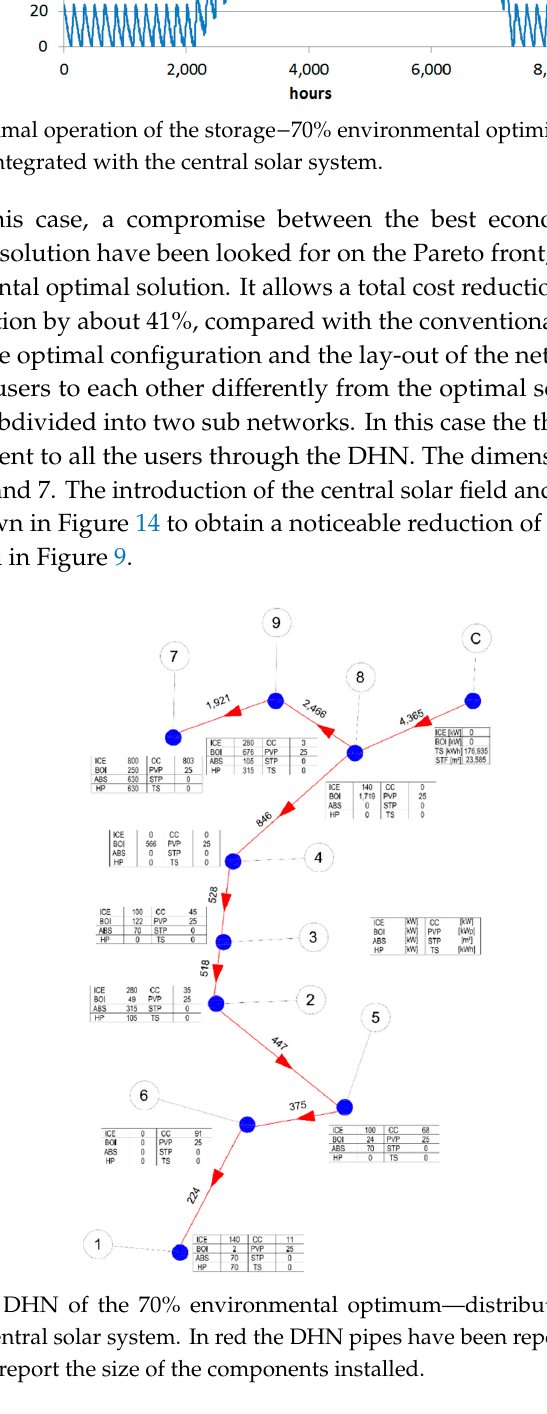
Figure 14. Optimal DHN of the 70% environmental optimum—distributed generation solution integrated with the central solar system. In red the DHN pipes have been reported together with their size (kW). The tables report the size of the components installed.